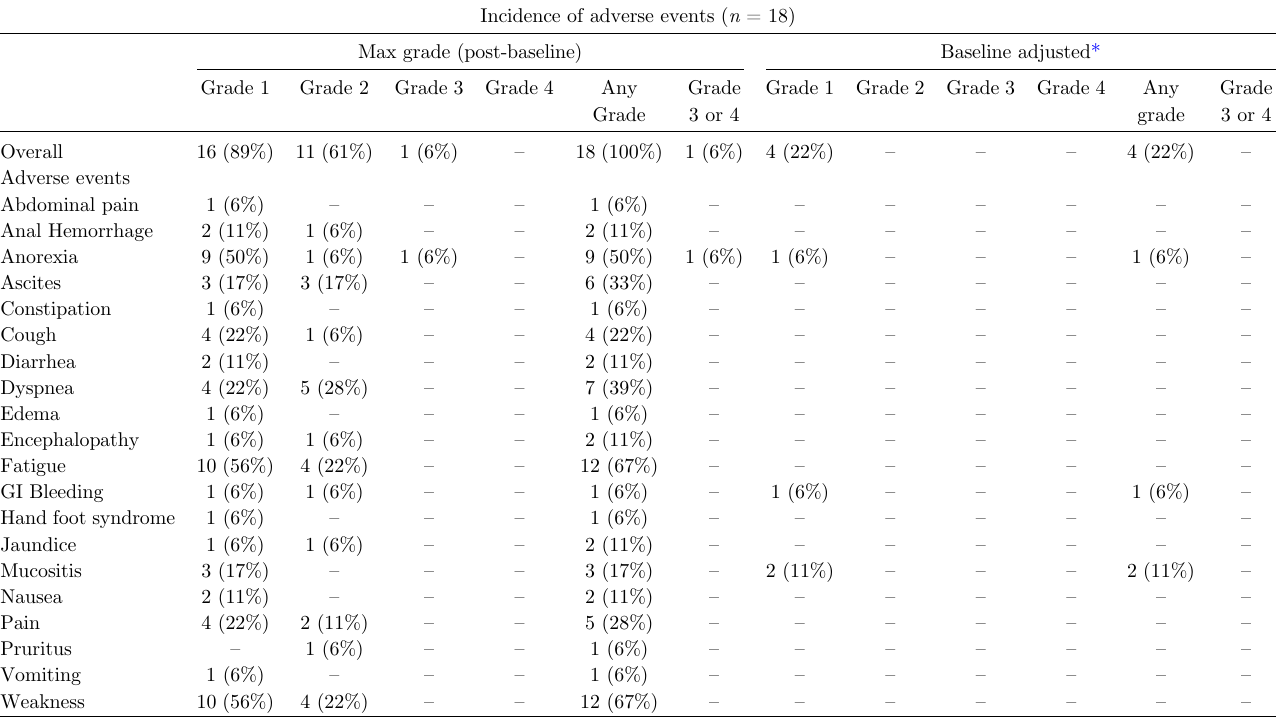
Table 4. Adverse Events Summary – Current Study real-world patients ( n = 18). Adverse Events reported by NCI CTCAE grade in real-world patients receiving treatment with the TheraBionic